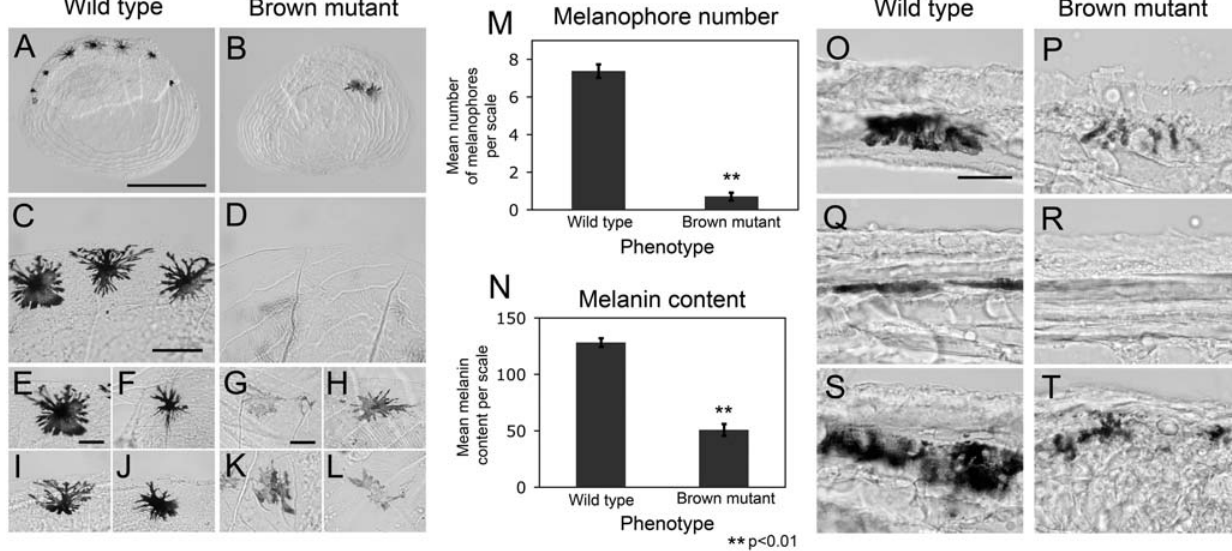
Figure 7. Variation in melanophore number and melanin content in scales derived from Surface (wild type) and brown mutant fish. Individual scales were collected from (A) wild type and (B) brown mutant individuals and assessed for (M) total number of melanophores. (B,D,M) Scales drawn from individuals demonstrating the brown phenotype (carrying two copies of the Pacho´n D 23,24 allele) had significantly less numbers of melanophores per scale. (A,C) In wild type scales, melanophores were frequently localized to the periphery of the scale, while (B,D) brown mutant melanophores were rarely at the periphery. Multiple melanophores observed in both (E,F,I,J) wild type and (G,H,K,L) brown mutant scales demonstrated a variety of morphologies, demonstrated by representatives from both phenotypes. (N) The amount of melanin is significantly lower in brown mutant melanophores. Skin tissues derived from the identical region of the dorsal flank demonstrated qualitatively lower amounts of melanin per melanophore in (P,R,T) brown mutants (carrying two copies of the Pacho´n D 23,24 allele) compared to (O,Q,S) wild type individuals. Three representative regions were analyzed in each individual. Overall, less melanophores were observed in brown mutant individuals, demonstrated by the absence of pigment in R. Scale bars: A,B=500 m m; C,D=100 m m; E–L=50 m m; O–T=30 m m.